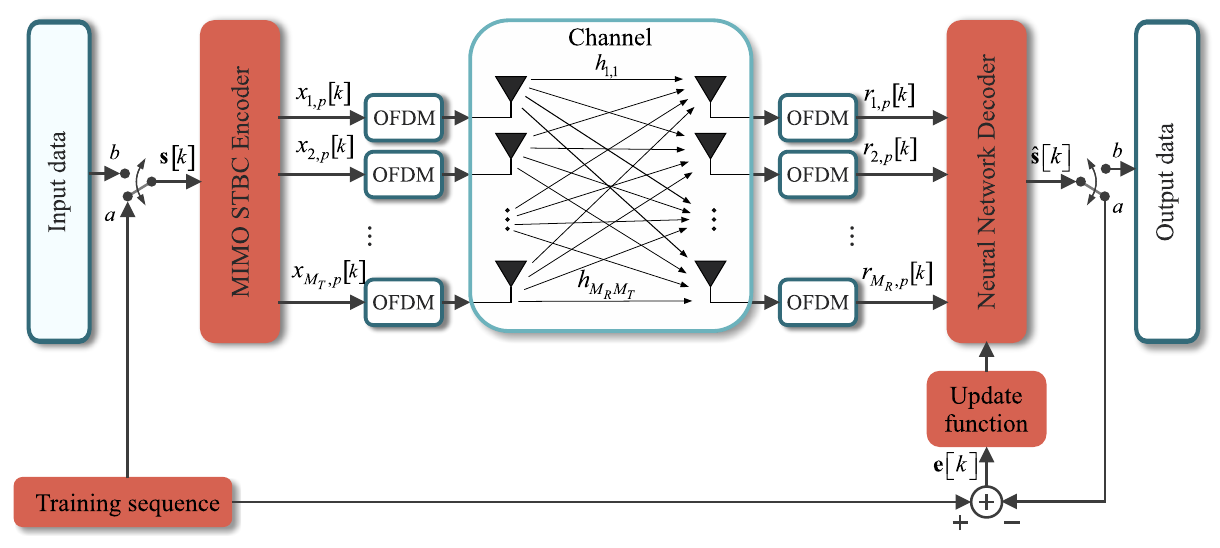
Figure 4. Complete vision of the proposed MIMO-OFDM model [11].